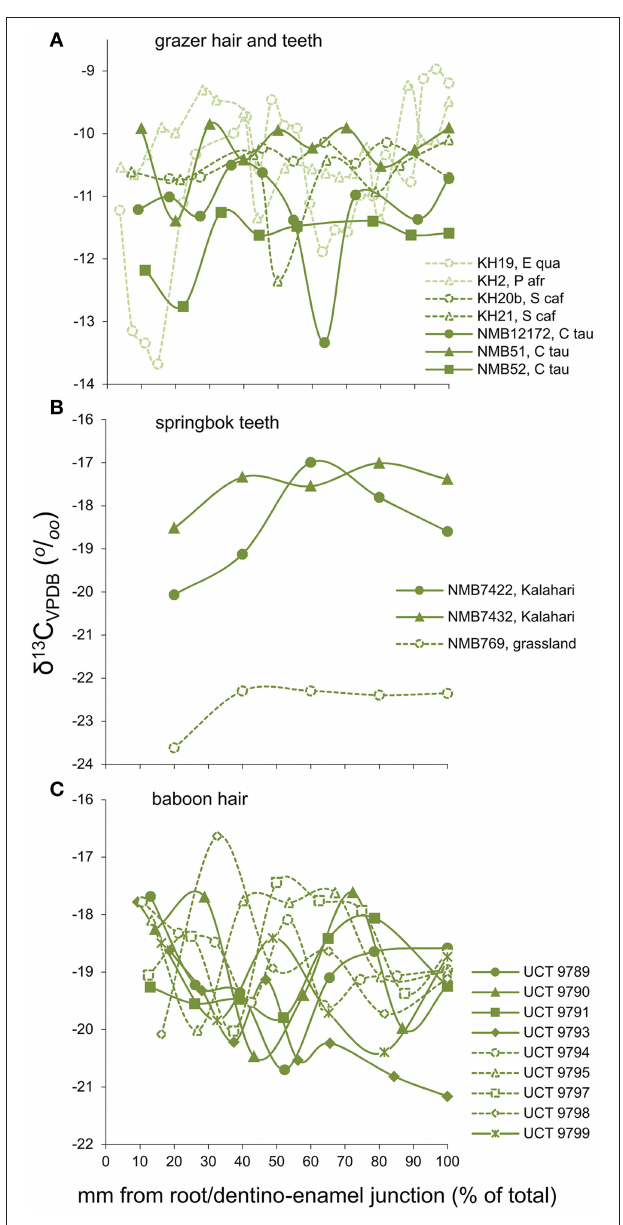
FIGURE 6 | Time-series profiles of δ 13 C-values along growth axes of individual herbivore hairs and tooth dentine collagen, amongst (A) grazers, (B) intermediate-feeders, and (C) chacma baboons. Values for dentine collagen are converted to hair “equivalents” for comparison. The x -axes represent growth from the most recent to oldest parts of each sample. Data for baboons are from Codron et al.